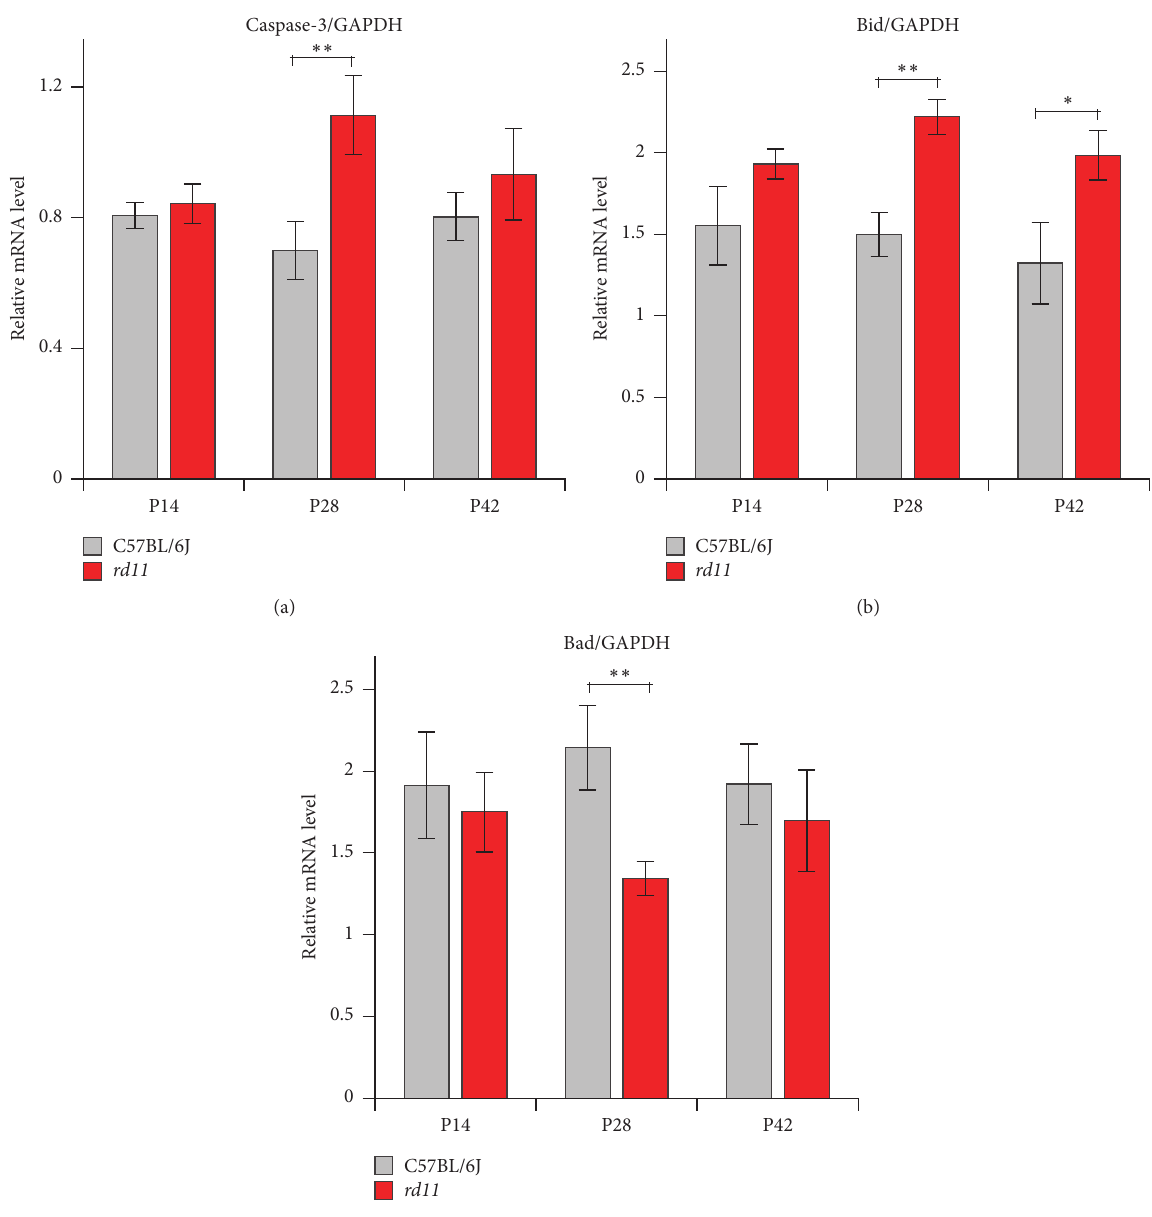
Figure 6: Gene expression related to apoptotic signal pathway. (a)–(c) Gene expression of Caspase-3 (a), Bid (b), and Bad (c) at mRNA levels by RT-PCR in P14, P28, and P42 C57BL/6J and rd11 retina. ∗ 𝑝 < 0.05 ; ∗∗ 𝑝 < 0.01 . 𝑛 = 10 retina per